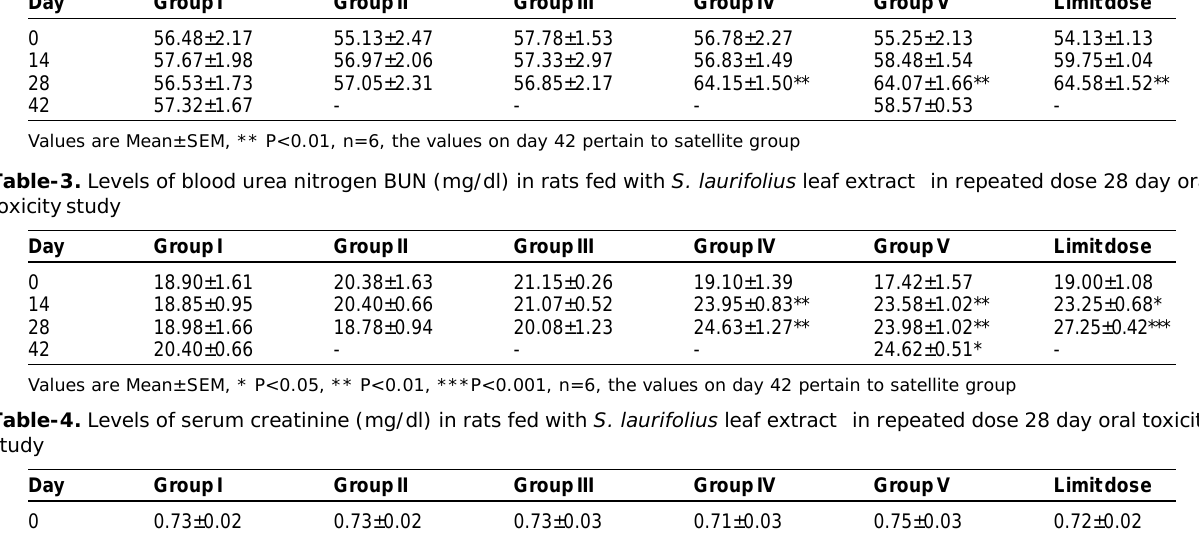
Values are Mean±SEM, * P<0.05, ** P<0.01, n=6, the values on day 42 pertain to satellite group Table-2. Levels of aspartate aminotransferase AST (U/L) in rats fed with S. laurifolius leaf extract in repeated dose 28 day oral toxicity study Day Group I